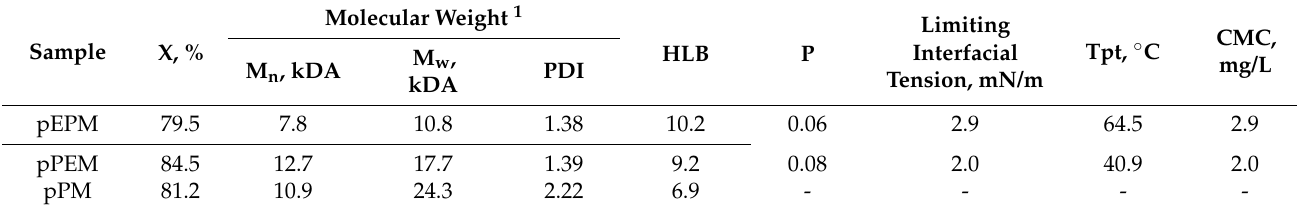
Table 1. The polymers characteristics.